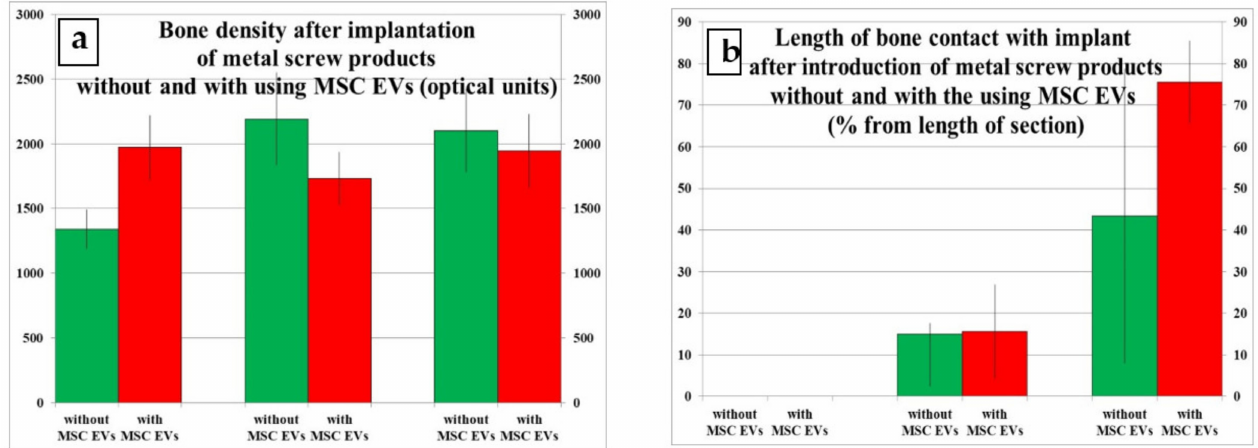
Figure 2. The state of the animal tibia at various times after the introduction of dental implants into the proximal condyle with the preliminary injection of MSC EVs. ( a ) By the 3rd day after the operation, according to the X-ray examination, the tissue rarefaction near the implant neck is insignificant (arrow), in the apex area—only along its sides (arrows). ( b ) Computer 3D modeling of the device position in the bone 3 days after implantation. ( c ) Three days after the operation, the fragments of bone detritus adhere tightly to each other, between them there are practically no corpuscles and blood vessels, stained with hematoxylin and eosin. ( d ) On the 7th day after implantation, next to the split parts of the bone tissue infiltrated by large cells, there are structures of new bone, possibly formed from these bone fragments, stained with hematoxylin and eosin. ( e ) By the 10th day, only for a short distance, the implant borders with the connective tissue (arrows), stained with hematoxylin and eosin. ( f ) Partial lysis, consolidation with each other, and ingrowth of split bone fragments into new forming bone structures 10 days after surgery, stained with hematoxylin and